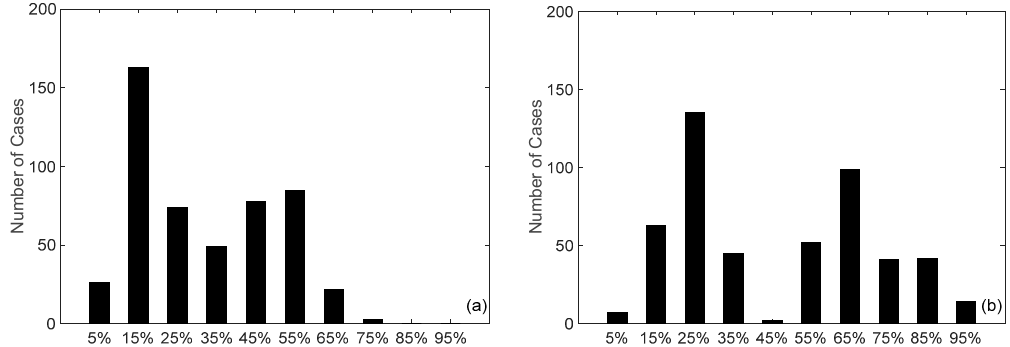
Figure 10. Delayed leak detection time for the 500 cases with random uncertainties under flow decrease conditions in systems where: ( a ) R = 0.49; and ( b ) R = 2.20 .